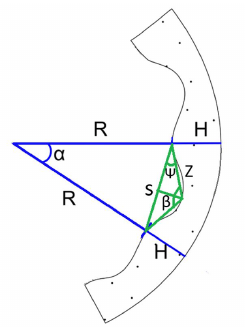
Figure 7. Model for the determinate used to determinate the β